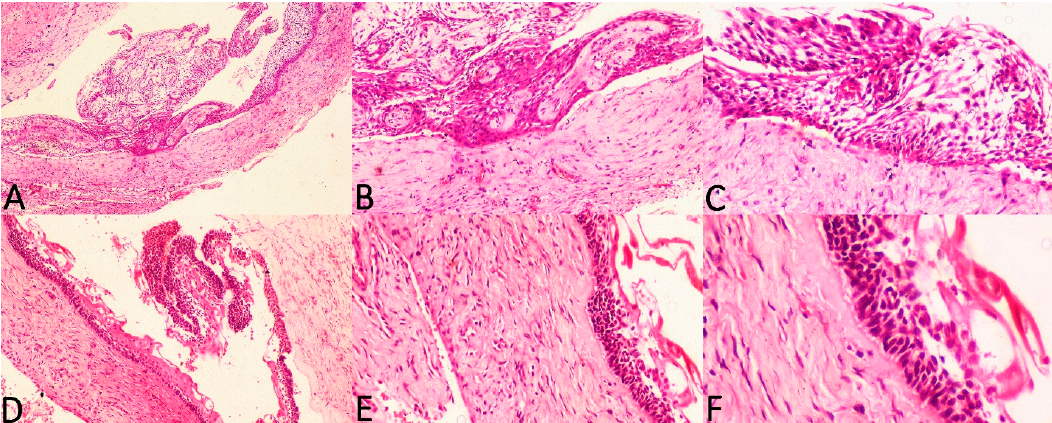
Figure 4. Photomicrographs of haematoxylin and eosin stain. Unicystic ameloblastoma—luminal type with absence of SEH, ( A ) 40×, ( B ) 100× and ( C ) 200×. Unicystic ameloblastoma—luminal type with prominent SEH, ( D ) 100×, ( E ) 200× and ( F ) 400×.